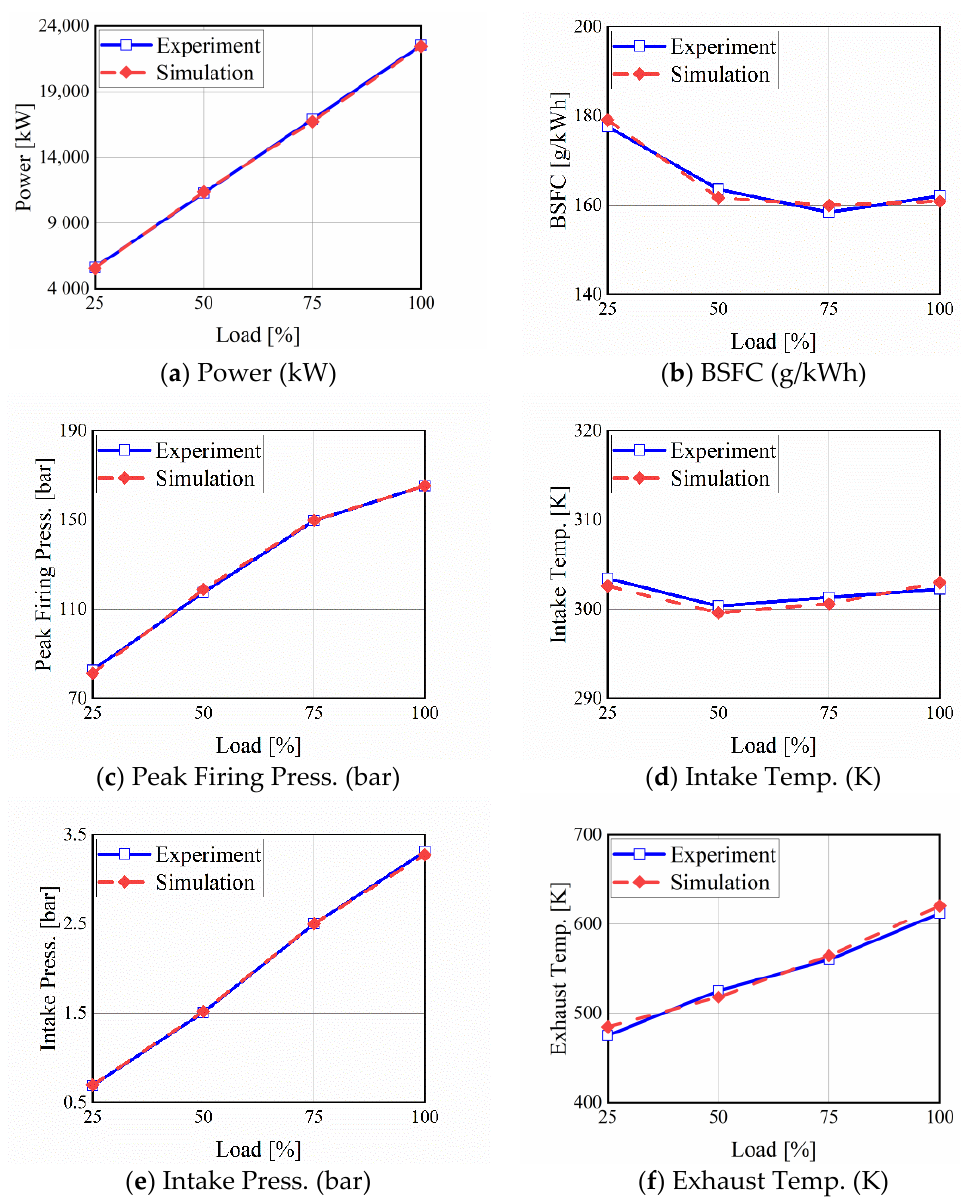
Figure 4. Comparison of the simulation and experiment in gas mode. Table 4. Calculation errors of the parameters in gas mode.